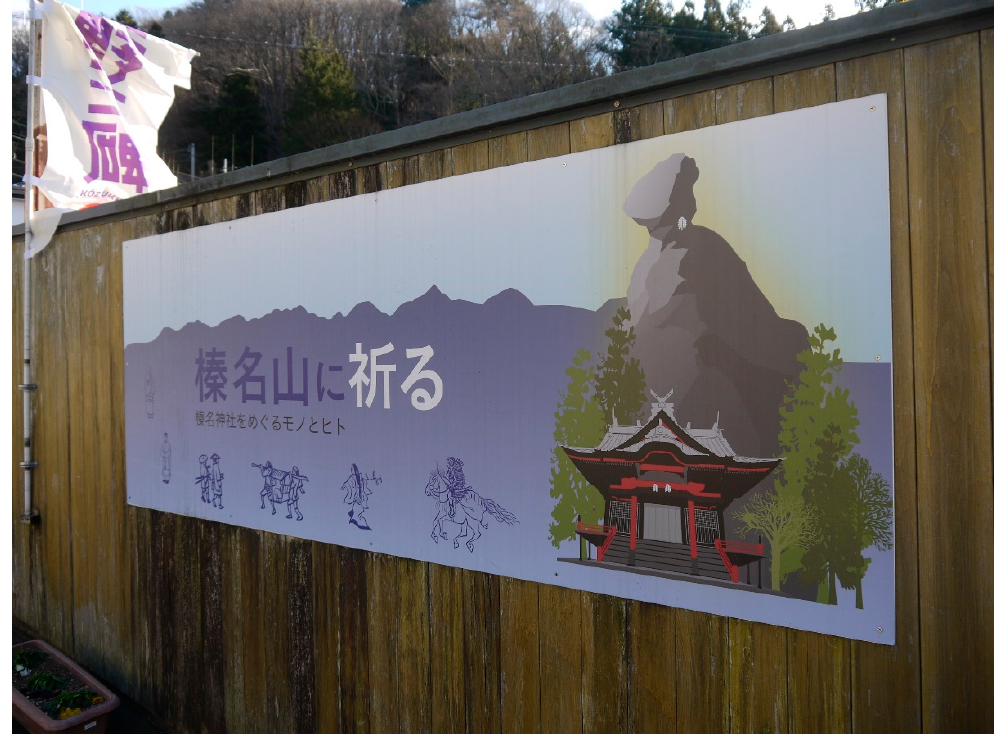
Figure 3. Banner “Harunasan ni Inoru: Haruna Jinja wo meguru Mono to Hito (Pray to Mt. Haruna: People and Objects at Haruna Shrine)” at Haruna Shrine Town. Photo by author on 19 December